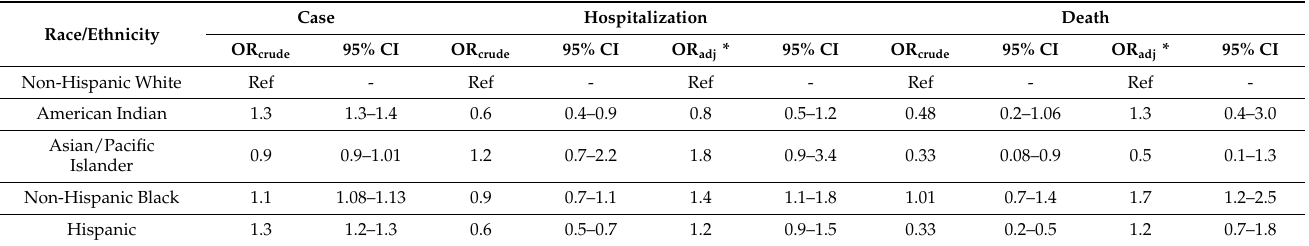
Table 3. Crude and adjusted * odds ratios (95% confidence intervals) between race/ethnicity and COVID-19-related outcomes (case, hospitalization, and